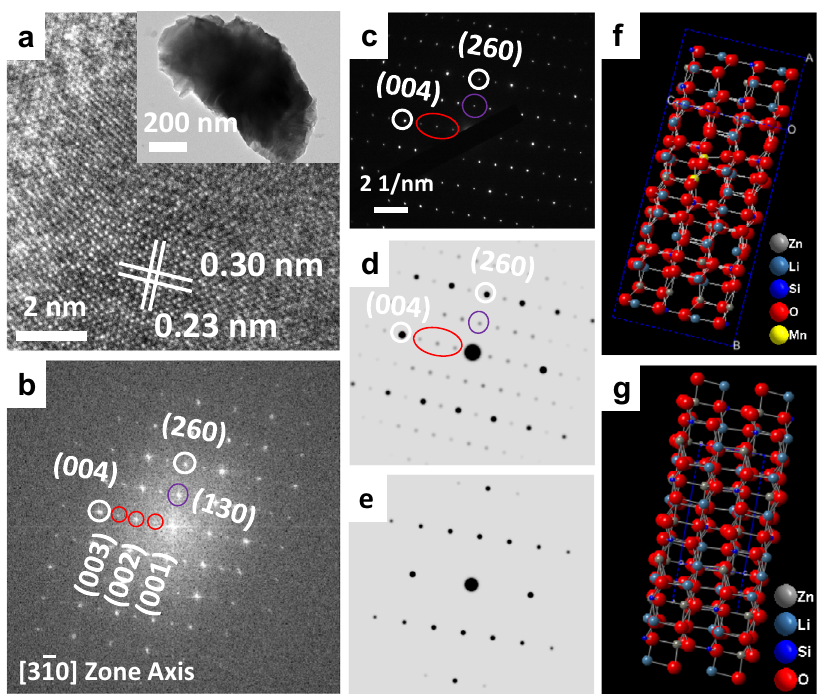
Fig. 2 TEM characterisation of Li 2 ZnSiO 4 :Mn 2 + . a HR-TEM image of a Li 2 Zn 0.85 SiO 4 :0.15Mn 2 + particle. The inset shows the low-resolution TEM image of the Li 2 Zn 0.85 SiO 4 :0.15Mn 2 + particle. b fast Fourier-transform diffraction patterns of the Li 2 Zn 0.85 SiO 4 :0.15Mn 2 + particle viewed along ½ 3 1 taken from the HR-TEM in Fig. 2a. c Selected area electron-diffraction pattern of the Li 2 Zn 0.85 SiO 4 :0.15Mn 2 + . d , f The simulated electron-diffraction pattern and the corresponding crystallographic model of M7 viewed along ½ 3 1 corresponding crystallographic model of Li 2 ZnSiO 4 viewed along ½ 3 1